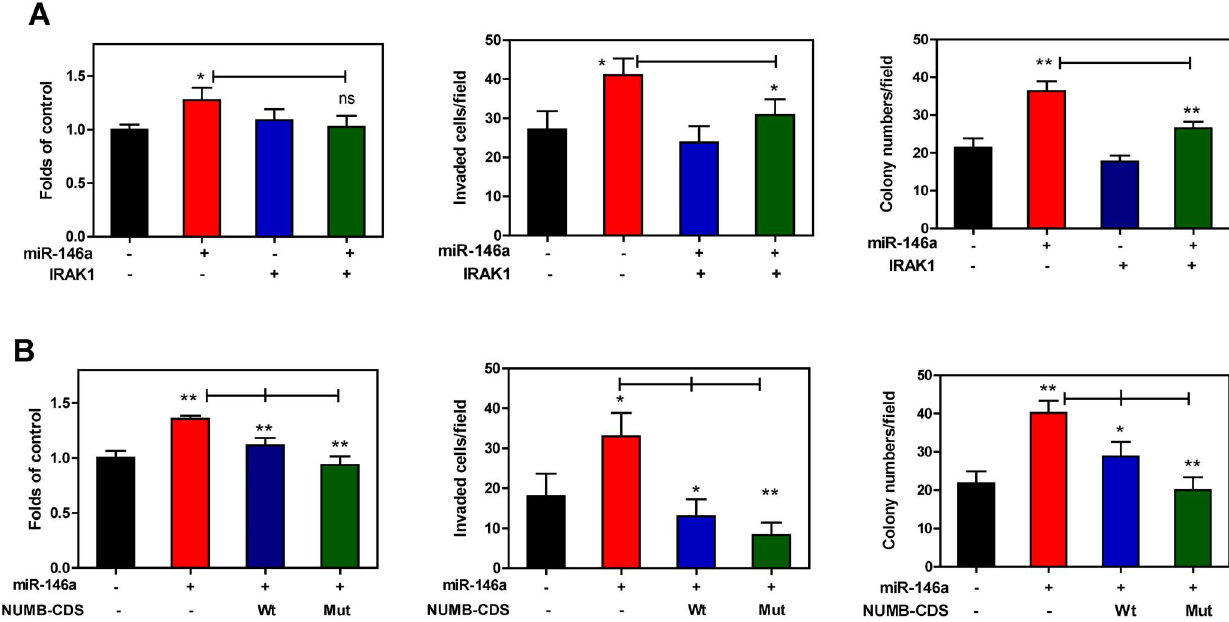
Figure 11. miR-146a -mediated oncogenic enhancement is rescued by IRAK1 or NUMB expression in SAS cells. Lt panels, Middle panels and Rt panels, proliferation assay, invasion assay and AIG analysis, respectively. Proliferation assay is performed at the 5 th day after cell seeding. (A) IRAK1. Transfection of pre- miR-146a mimic and pCMVSPORT6-IRAK1 plasmid were performed. IRAK1 expression is shown in Fig. 7B. The analysis indicates that the invasion and AIG, but not proliferation, induced by miR-146a expression are attenuated by exogenous IRAK1 expression. (B) NUMB. Transfection of pre- miR-146a mimic and infection with NUMB-CDS-Wt or NUMB-CDS-Mut viruses are performed. Fig. 9F shows that the expression of NUMB in NUMB-CDS-Mut group is higher than that in NUMB-CDS-Wt group. The oncogenic phenotypes that have been enhanced by miR-146a expression are significantly attenuated by NUMB expression, especially by NUMB-CDS-Mut. Data shown are means 6 SE from triplicate analysis. ns , not significant; *, p , 0.05; **, p , 0.01; ***, p , 0.001; Mann-Whitney test.